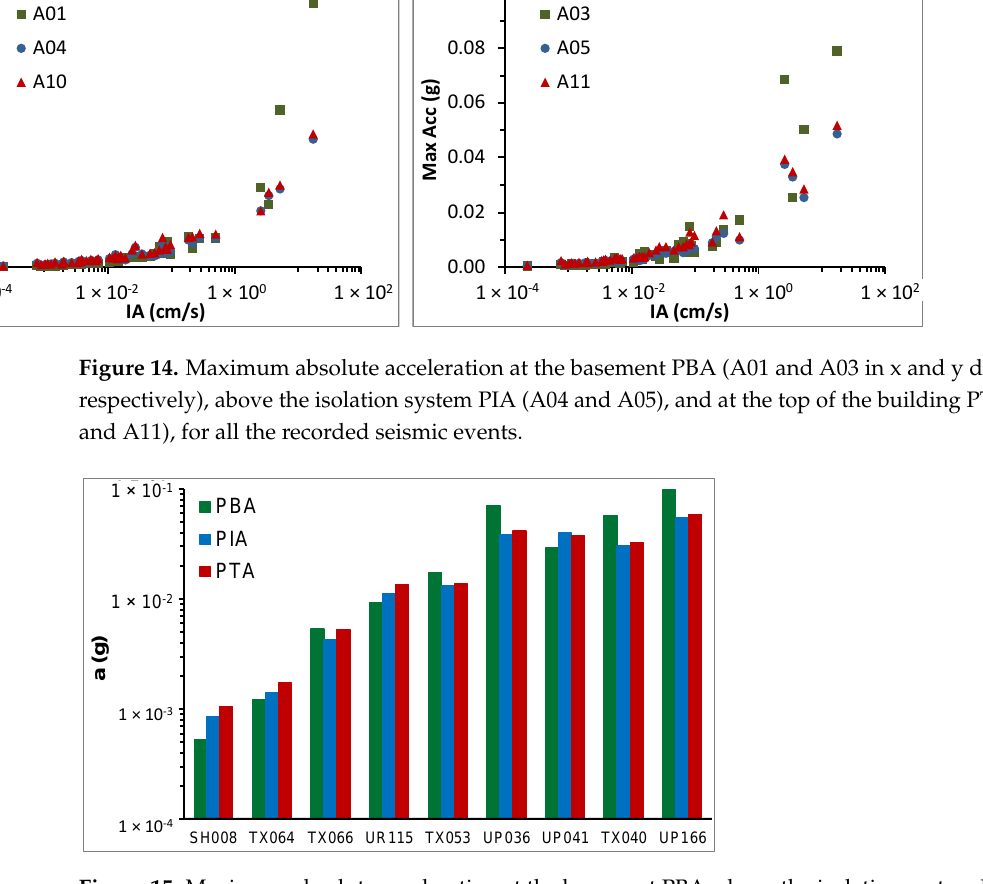
Figure 15. Maximum absolute acceleration at the basement PBA, above the isolation system PIA and at the top of the building PTA for the selected seismic events.